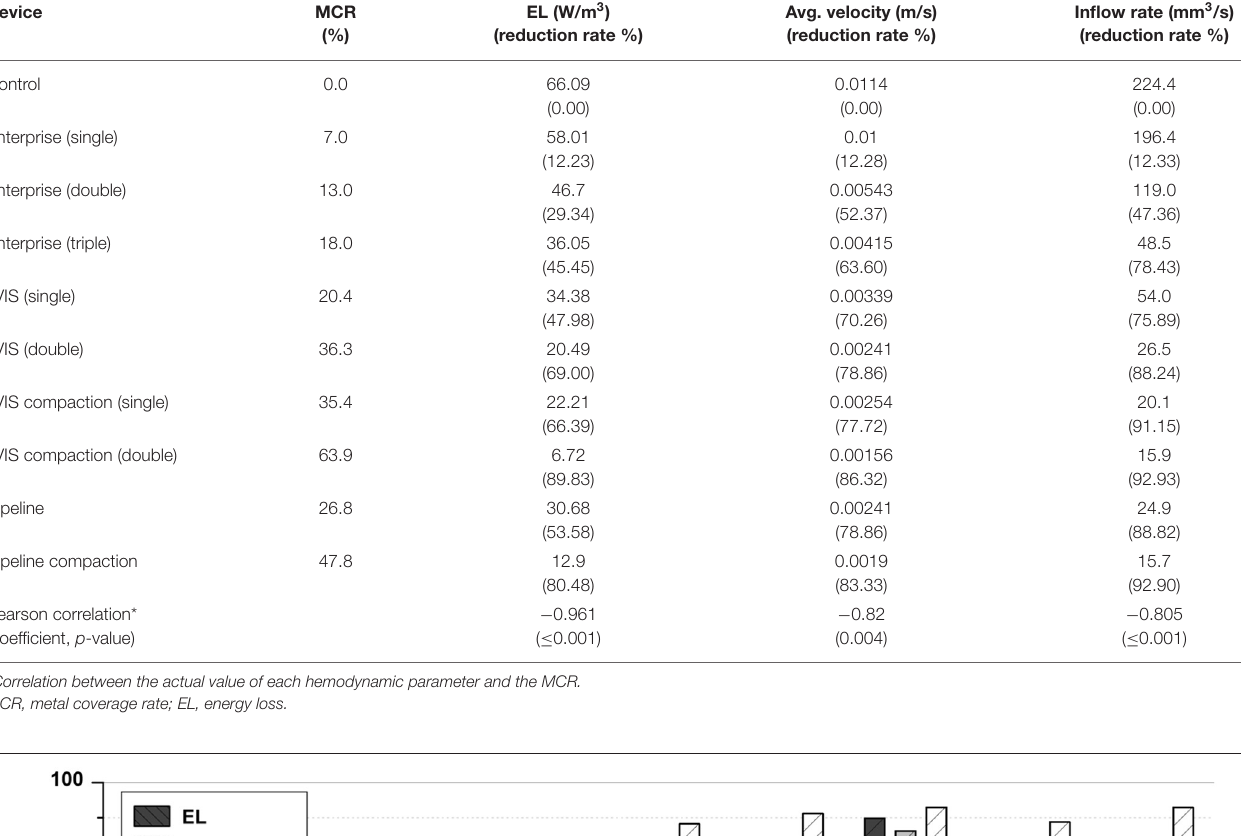
TABLE 1 | Summary of changes in the MCR and hemodynamic parameters caused by overlapping or compacting the stents used in this study.